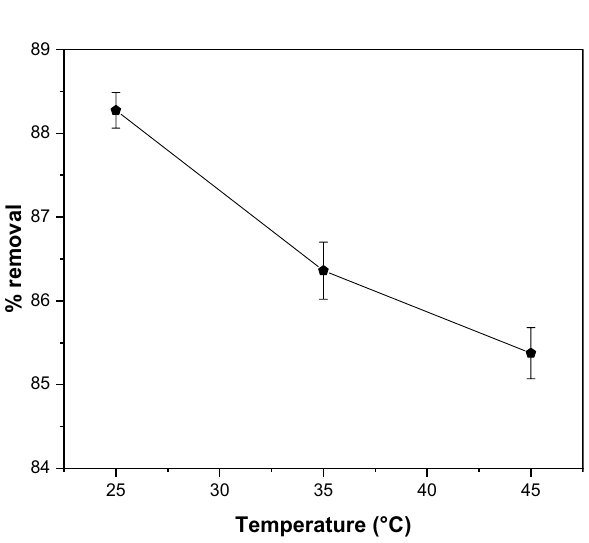
Figure 11. Effect of temperature on adsorptive CR removal using GSC WCO